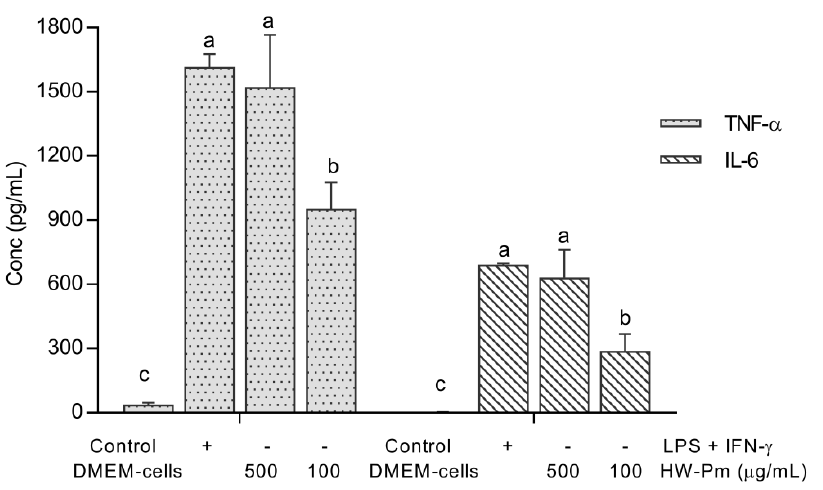
Figure 3. Effect of HW-Pm on TNF- α and IL-6 production in RAW 264.7 macrophages. The cytokine levels were determined by mouse TNF- α and IL-6 immunoassay Quantikine ® ELISA Kits. Means without the same letter are significantly different at the 5% level according to a one-way ANOVA test followed by a Tukey test ( n = 4).